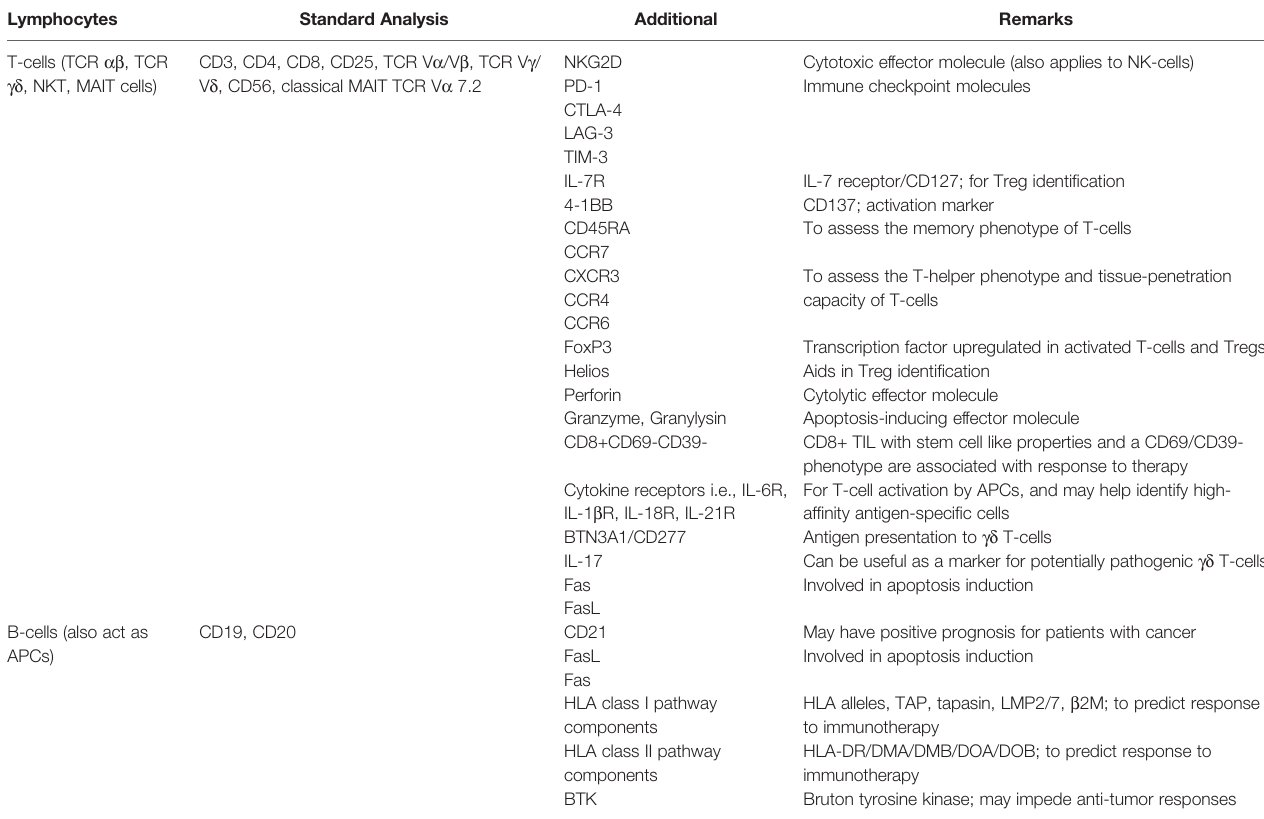
TABLE 1 | Lymphocyte markers for use in IHC and fl ow cytometry studies to support clinical decision making in personalized cancer immunotherapy.